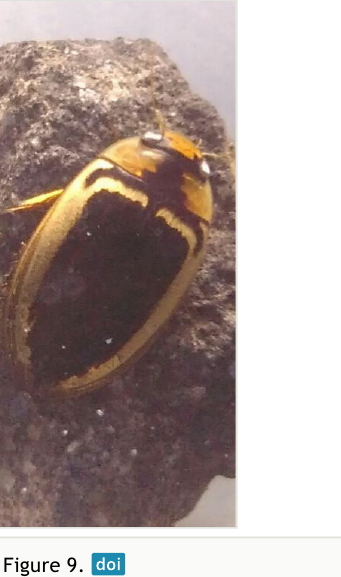
Figure 9. Hydaticus luczonicus , HP image from BALI_NS_2016_16.